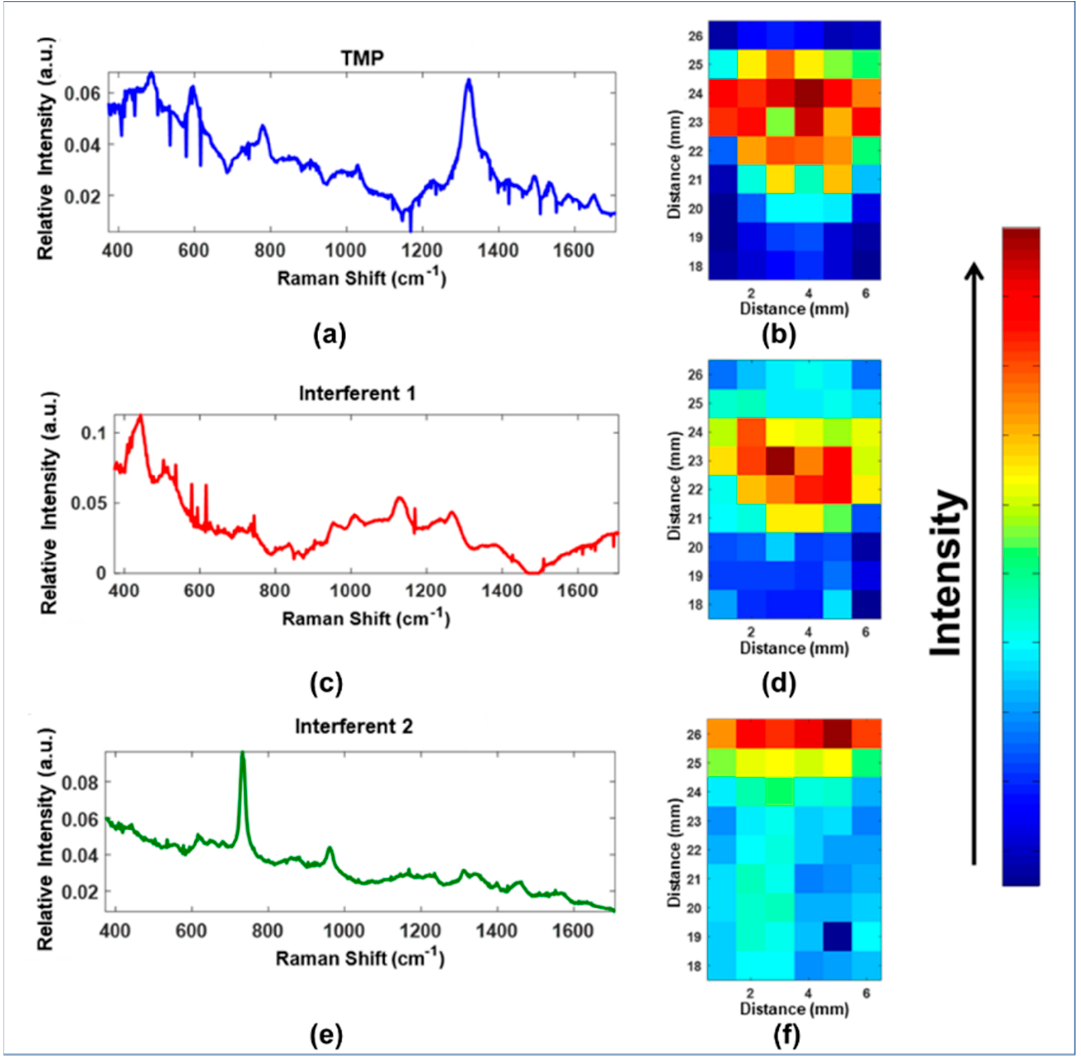
Figure 10. ( a ) Recovered SERS spectra for TMP standard, ( b ) concentration (chromatographic) pro-